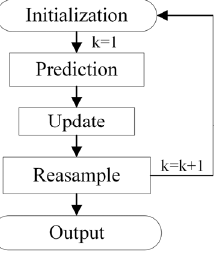
Figure 3. Flowchart of PF.